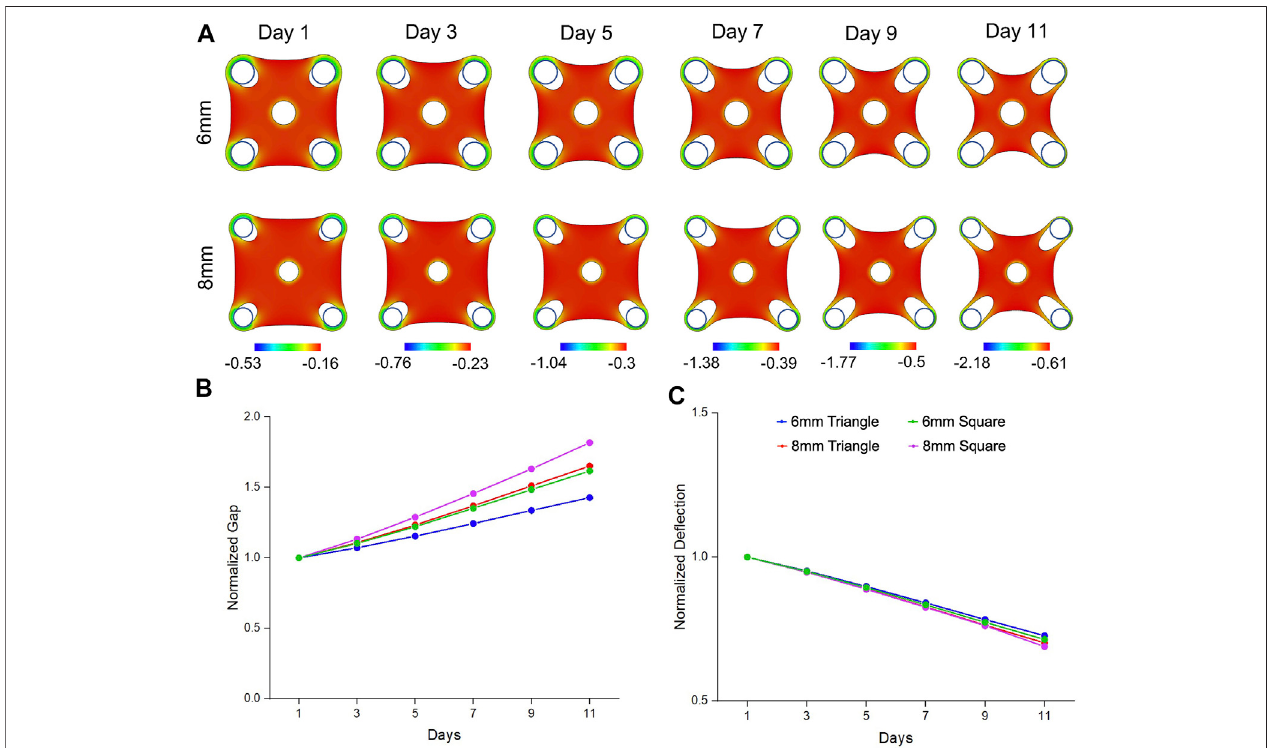
FIGURE 4 | Simulation results of morphogenic evolution of square mesenchymal tissues. (A) A volumetric contraction model with a time-dependent free-energy functionwasusedtosimulatethemorphologicalevolutionofthesquaretissues.Thecolorrepresentstheminimalprincipallogarithmicstraindistributioninthetissue.The computational model was able to replicate the trends in morphological changes of gap extension and de fl ection compaction that were observed from the experimental model. For the tissue comparison ( ▲ 6wC , ▲ 8wC , ∎ 6wC and ∎ 8wC), (B) the gap was larger and (C) the de fl ection was smaller for the square tissues with longer side